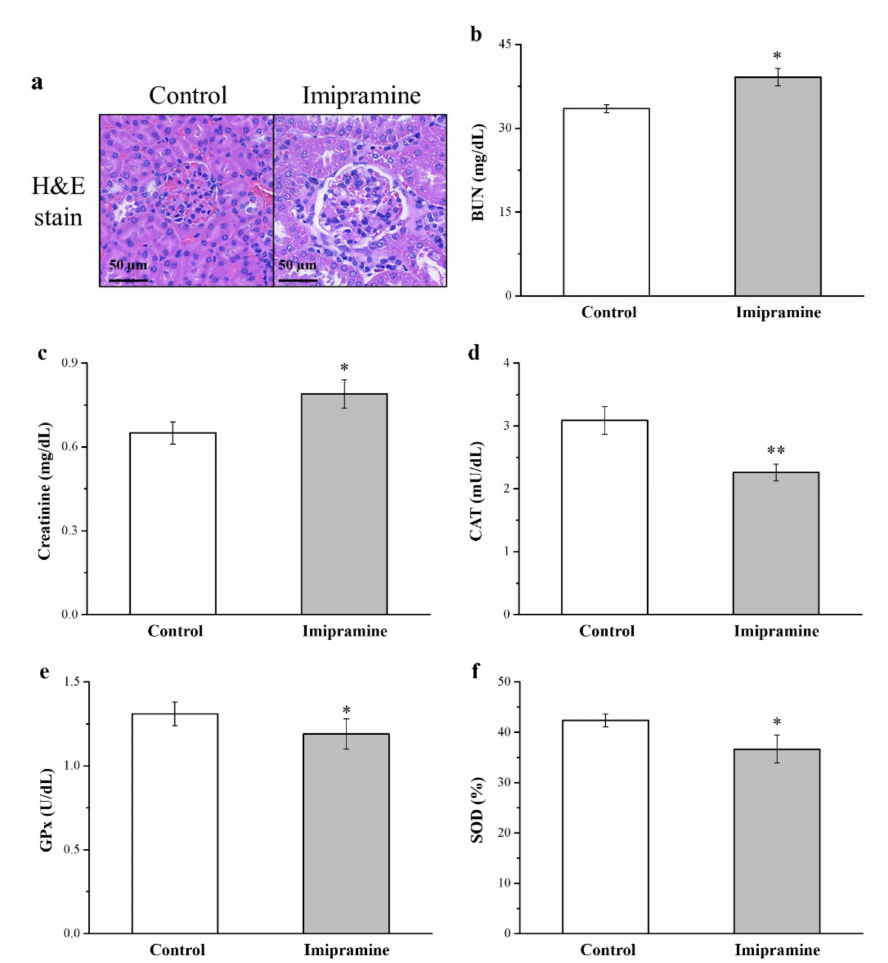
Figure 8. Effect of imipramine on ( a ) glomerular morphologies according to hematoxylin and eosin staining (magnification, 200 × ). ( b ) Serum BUN, ( c ) serum creatinine, ( d ) renal catalase (CAT) activity, ( e ) renal glutathione peroxidase (GPx) activity, and ( f ) renal superoxide dismutase (SOD) activity. Data are in the form of mean ± standard deviation ( n = 8). * p < 0.05; ** p <